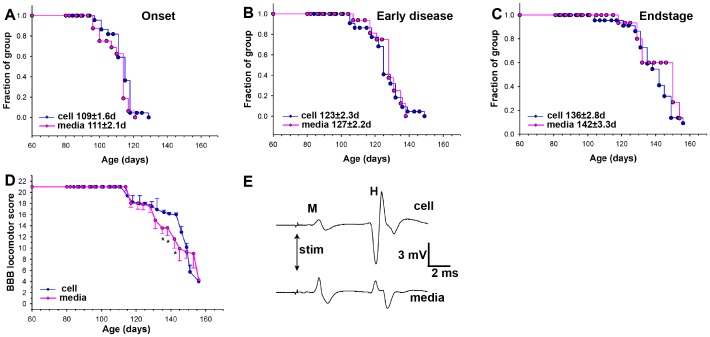
SOD1G93A rats receiving lumbar grafts of human spinal neural stem cells showed transient protection of hindlimb motor function and Hoffmann reflex.Population analyses of media-treated and cell-grafted animals showed no difference in: disease onset - defined as peak body weight (A), early disease progression - defined as the age at which animals had lost 10% body weight (B), or survival (C). Hindlimb motor function assessed by BBB neurological score (D) showed a significantly better score in hNSCs-grafted animals between ages 135–142 d. Similarly, Hoffman reflex recorded in cell-grafted animals during that time period had significantly higher average amplitudes than those from the media-treated group (E), (* P<0.05).